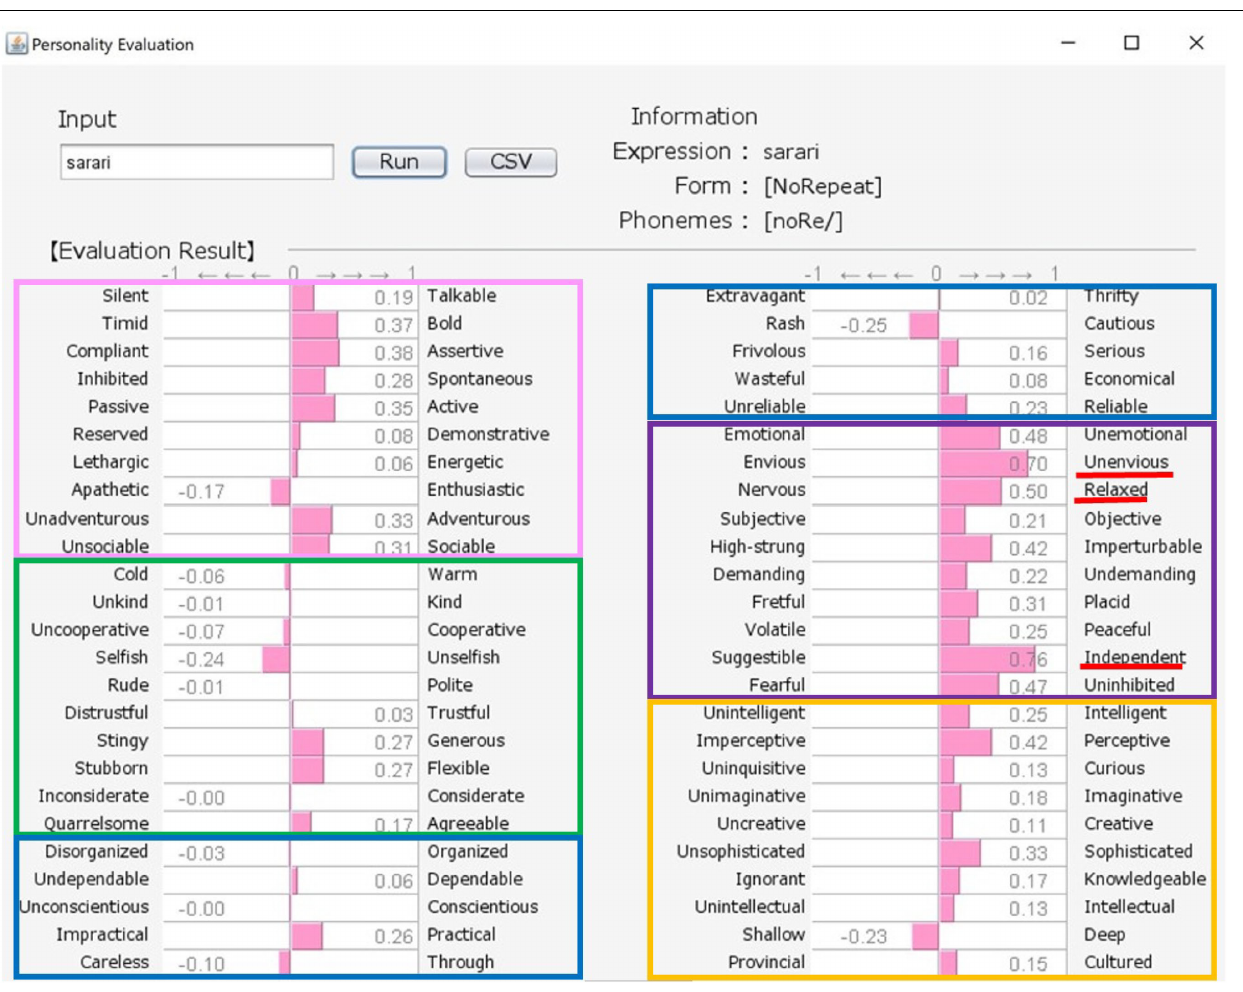
FIGURE 10 | Output for “sarari (nearly equal to frank)” personality. The pink, green, blue, purple, and orange frames indicate Extroversion, Agreeableness, Conscientiousness, Neuroticism, and Openness, respectively.